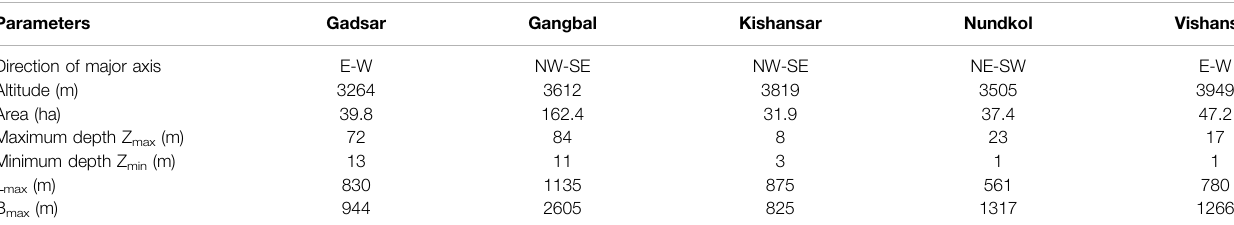
TABLE 3 | Morphometric measurements of the fi ve high altitude lakes in Kashmir Himalaya. Parameters Direction of major